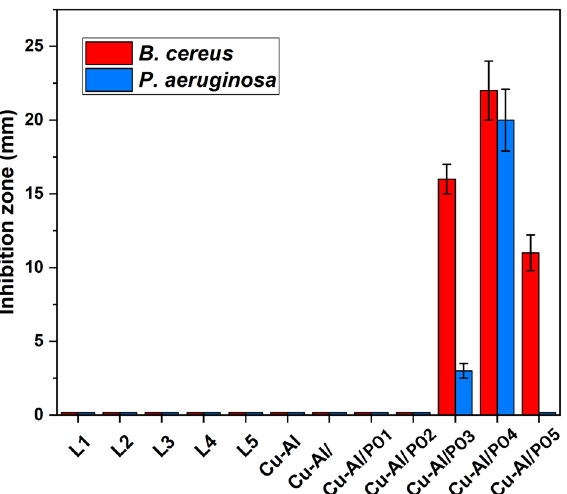
Figure 4. Antibacterial activity of the samples against Bacillus cereus and Pseudomonas aeruginosa at 5 mg/mL